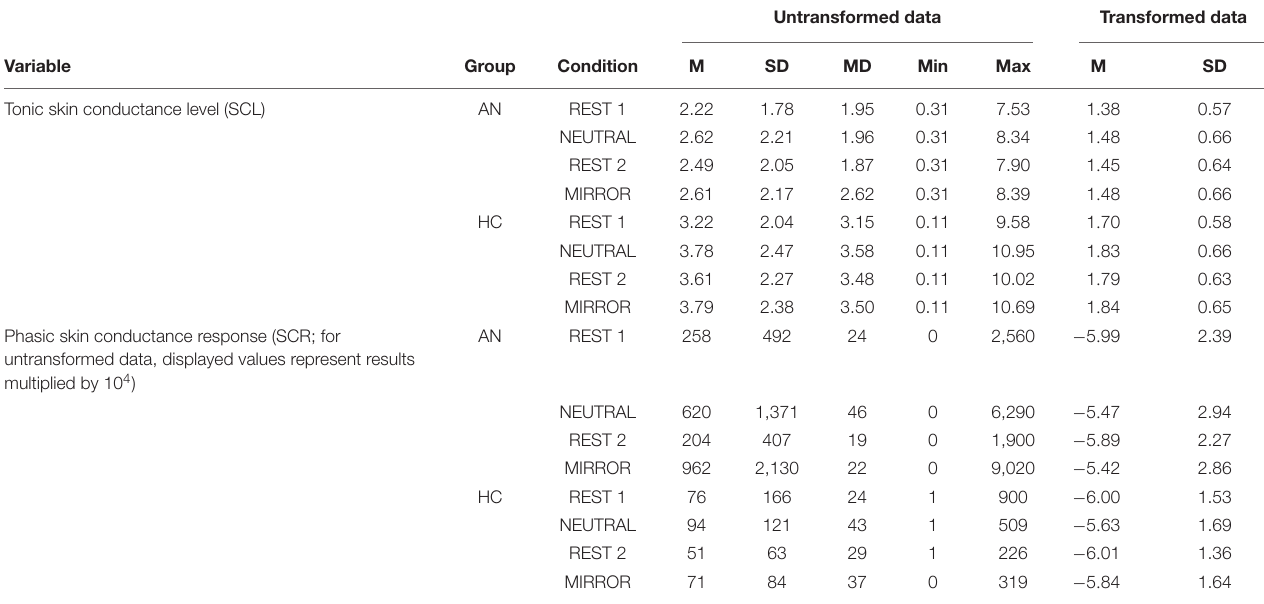
TABLE 1 | Descriptive statistics for skin conductance data by group and condition.